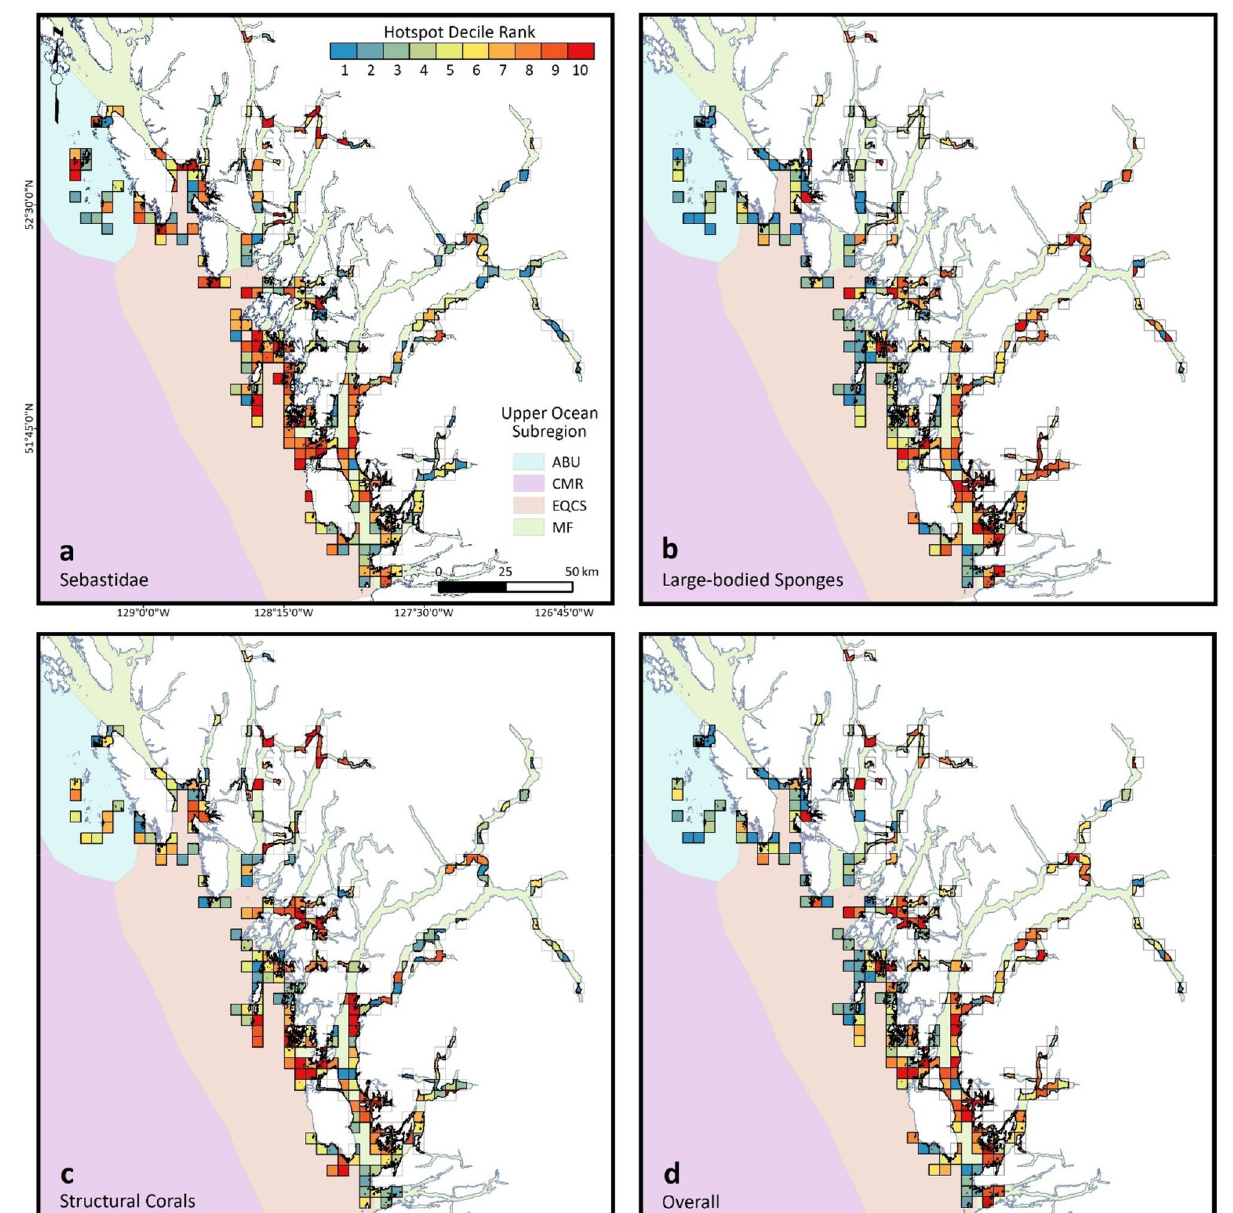
Figure 2. Spatial distribution of hotspot decile ranks within 16-km 2 planning units (squares, except where faded over land), by species group ( a ) Sebastidae, ( b ) large-bodied sponges, ( c ) structural corals, and by Upper Ocean Subregions ( ABU Aristazabal Banks Upwelling, CSTM Cape Scott Tidal Mixing, EQCS Eastern Queen Charlotte Sound, MF Mainland Fjords). Panel ( d ) displays decile ranks for the overall hotspot index, which integrates data from all taxonomic groups. Although primary analyses were conducted at the scale of 1-km 2 , First Nations of the Central Coast require this coarse scale for display of spatial data to protect sensitive locations. (Figure depicts outputs from Eqs. 4 and 5 and was created with ArcGIS Desktop, Version 10.8.1: https:// www. esri. com/ en- us/ arcgis/ produ cts/ arcgis- deskt op/ overv pacifica , and Stylaster spp.—had higher expected counts, on average, at Mainland Fjords that at Eastern Queen Charlotte Sound (Appendix S10). However, the remainder of coral taxa—including the top-ranking coral for conservation prioritization, Primnoa pacifica —have expected depths of 180 m or greater (Appendix S6); these depths were adequately sampled only at Mainland Fjords (Appendix S7); which likely biased results. Similarly, we did not record hotspots for structural corals or large-bodied sponges at Aristazabal Banks Upwelling (Fig. 3), which likely is a false negative as sampling effort was lowest and shallowest (Appendices S7, S9) at this most remote of the three Upper Ocean Subregions. Overall hotspots—those with high evenness and summed index values for the three taxonomic groups—were more likely to occur, after accounting for depth, at Mainland Fjords than at other Upper Ocean Subregions (Fig. 3,